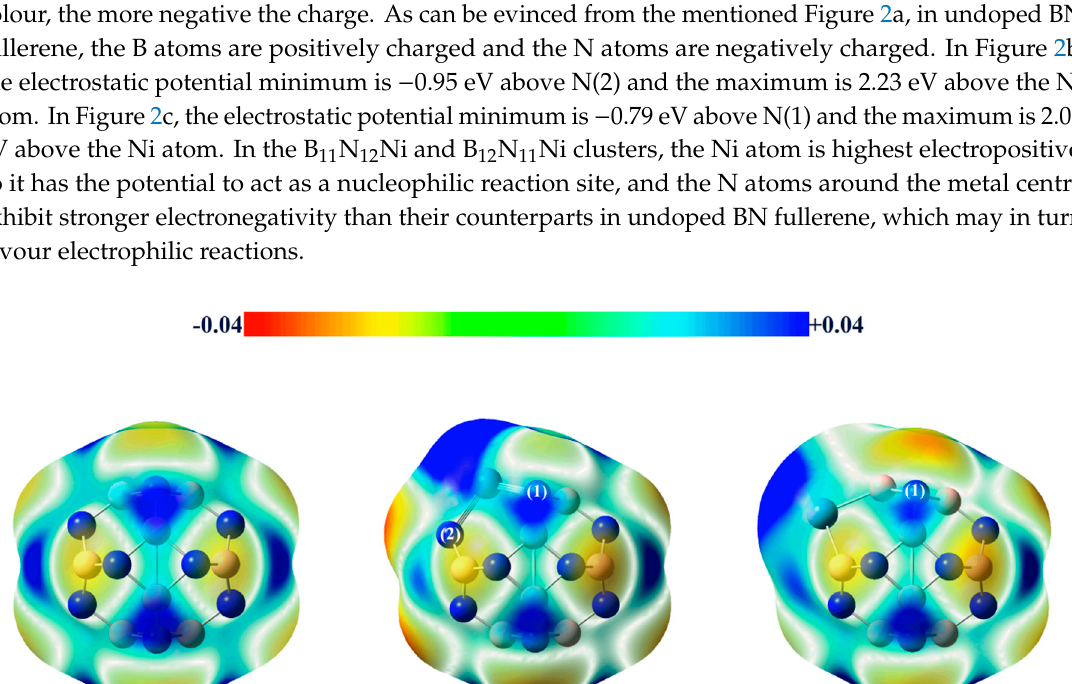
Table 1. The orbital energies on the HOMO and LUMO of B 12 N 12 , B 11 N 12 Ni and B 12 N 11 Ni, and their energy gaps (energies in eV).